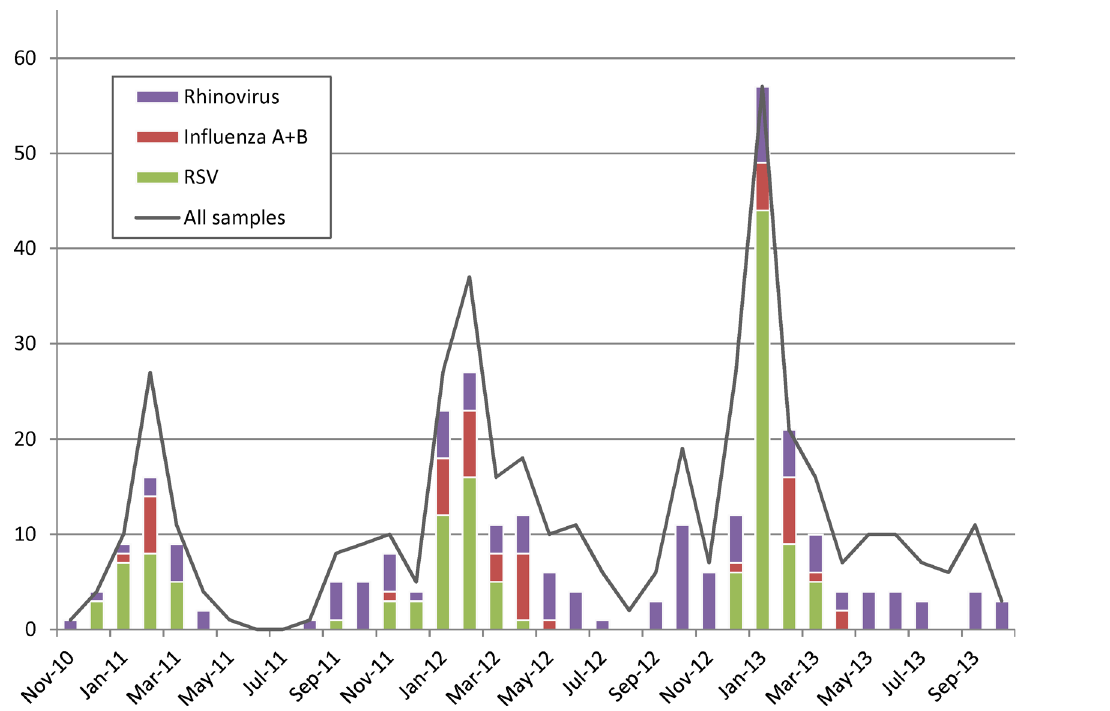
Fig 2. Seasonality of RSV, rhinovirus and influenza virus